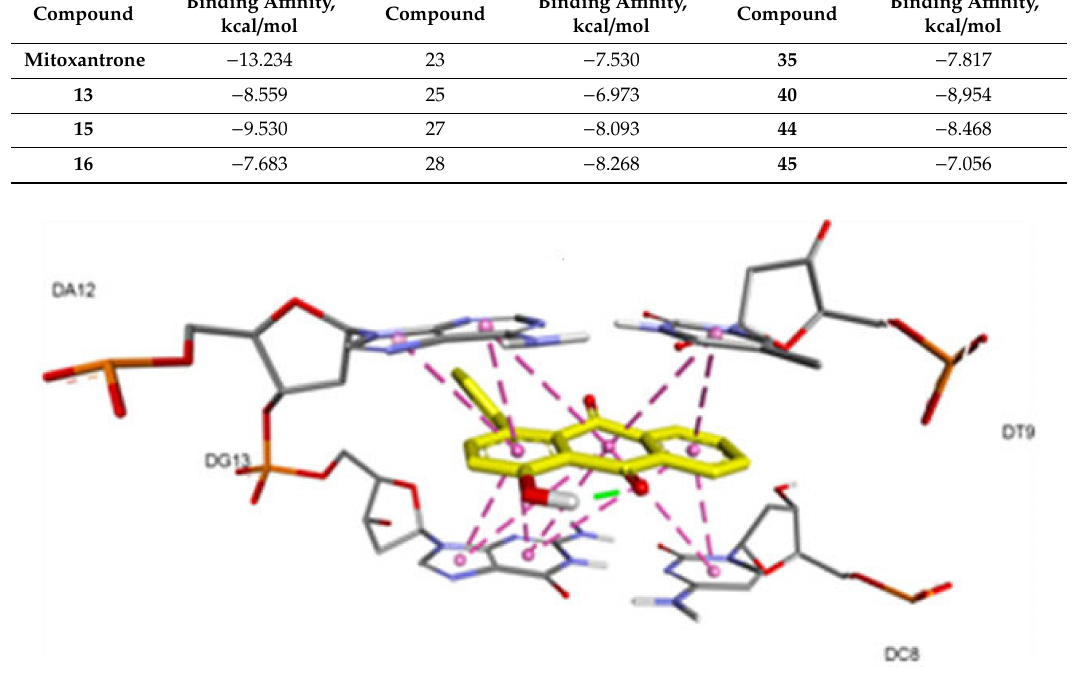
Figure 2. Docking of compound 13 in topoisomerase II β -DNA complex binding site. Non-covalent interactions of molecules are shown by dotted lines: green—hydrogen bonds, orange—electrostatic interactions, yellow—sulfur interactions, purple—stacking